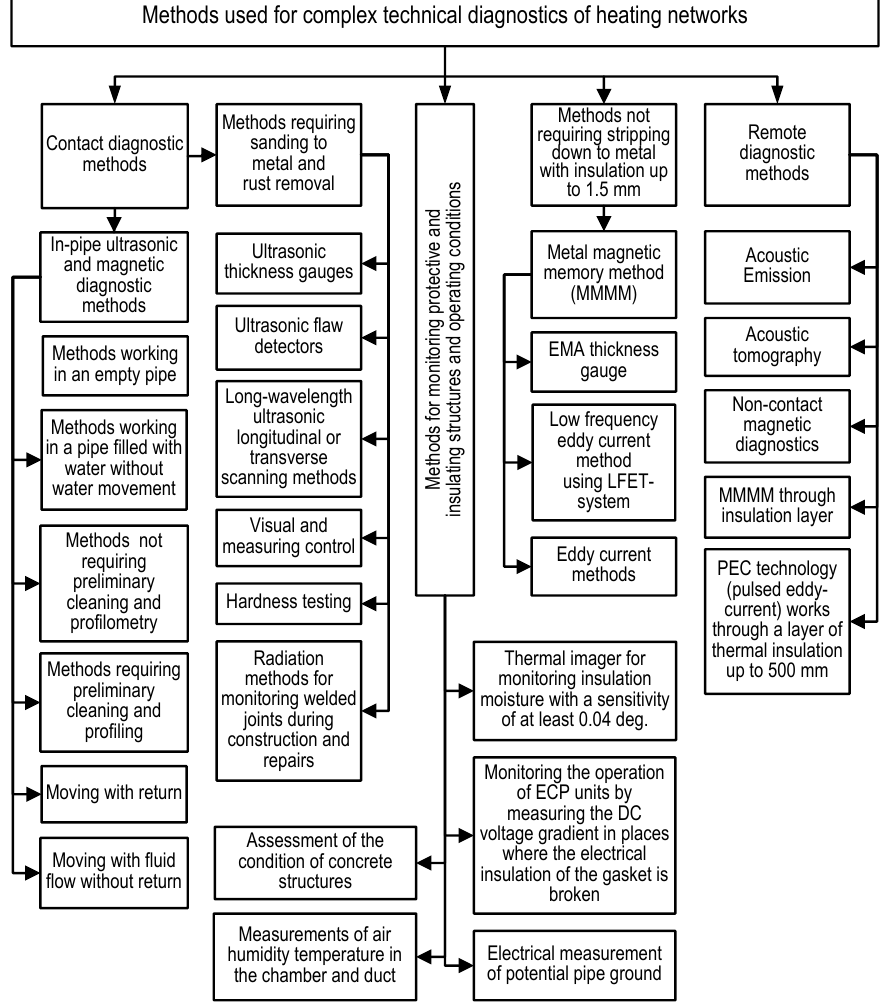
Figure 4. Methods that were used for complex technical diagnostics of heating networks.